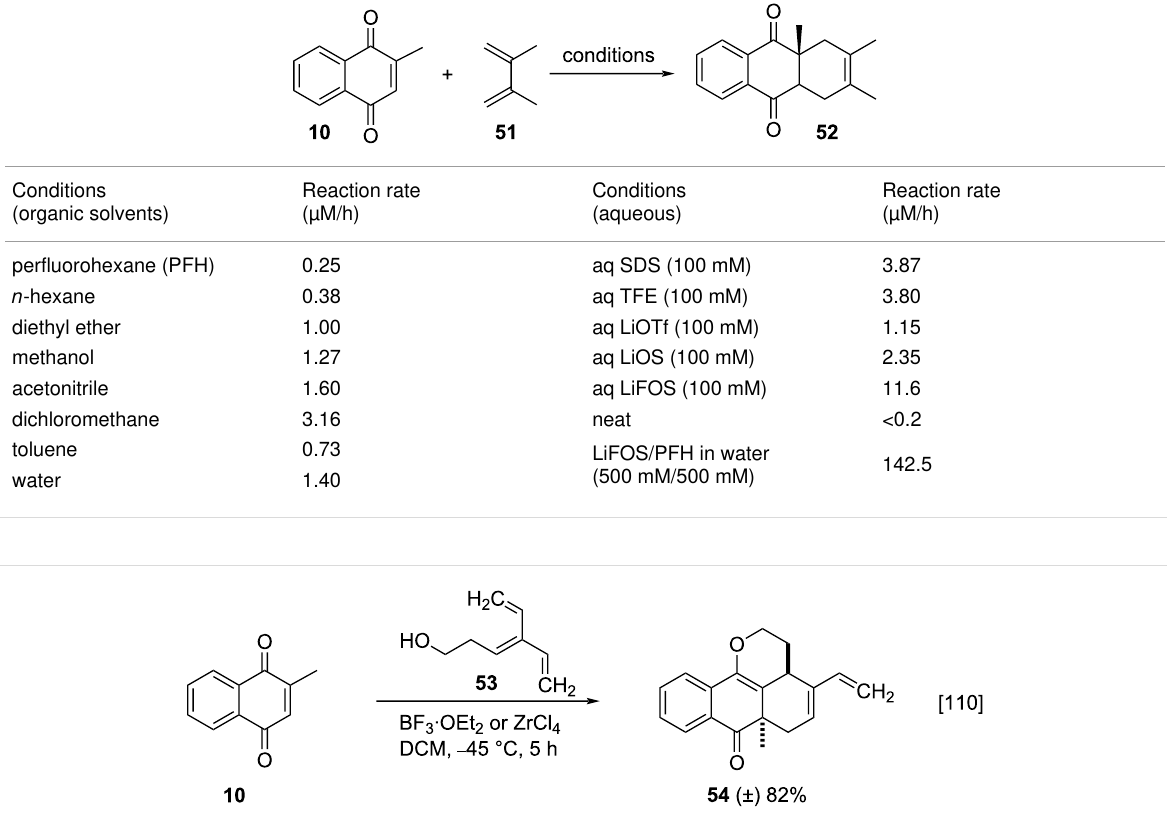
Conditions (organic